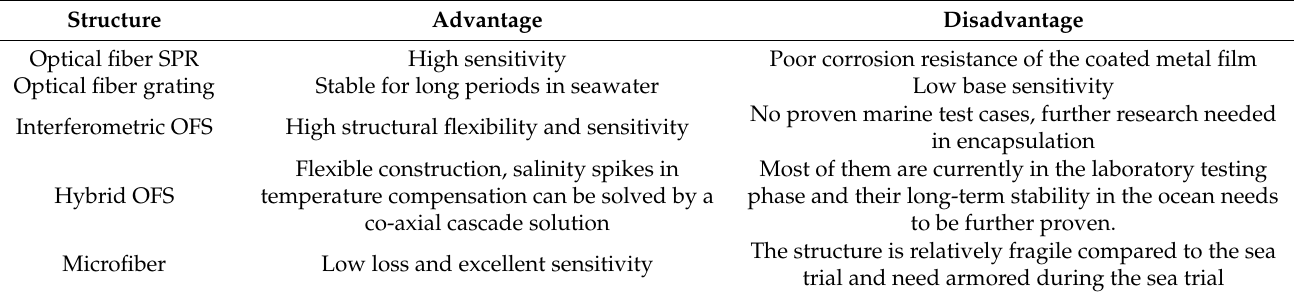
Table 9. Summary of the advantages and disadvantages of the different methods.